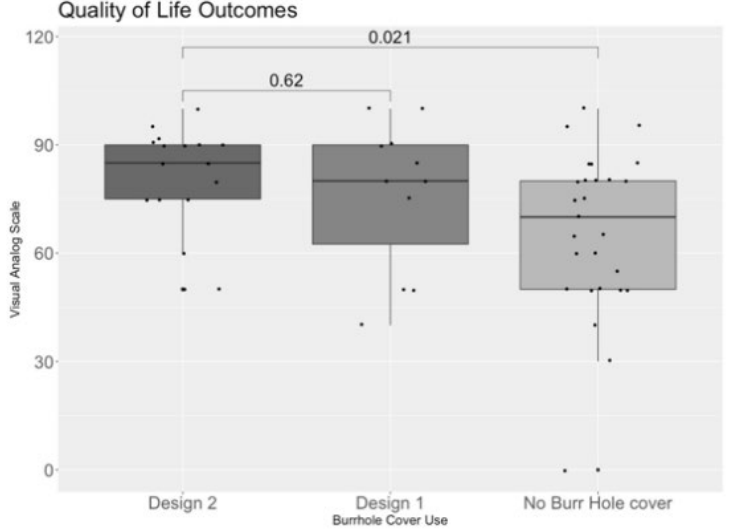
Figure 6. A boxplot comparing the Visual Analog Scale between those who had received Design 2, Design 1, and no Burrhole Cover . Statistical analysis: Mann–Whitney U test; significance = p < 0.05.